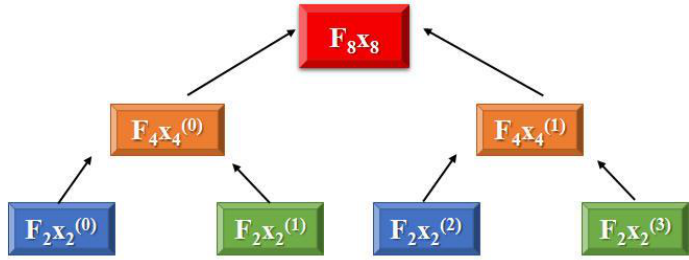
Figure A3. Fast Fourier transform of the divide-and-conquer process.